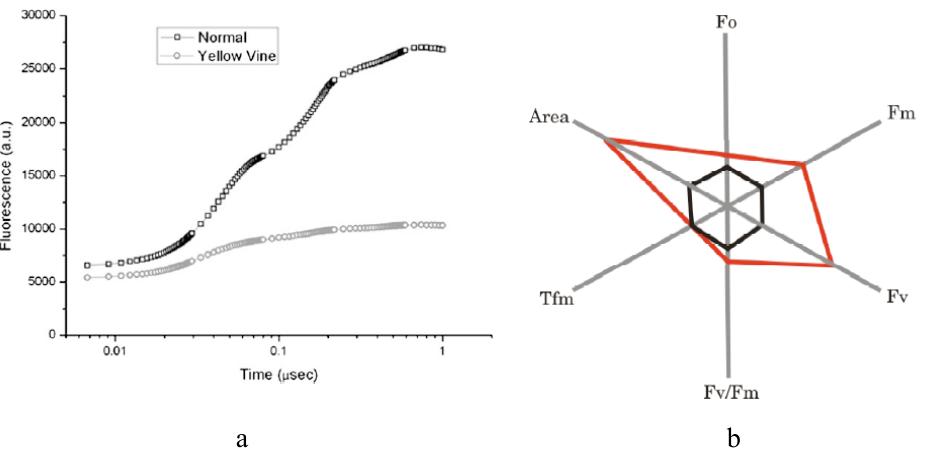
Figure 2. Typical chlorophyll transient curves ( a ) and a spider plot ( b ) of the chlorophyll fluorescence parameters for yellow vine cranberry leaves in the absence (black) and presence (red) of shade. (Adapted from [34], with permission from the American Society for Horticultural